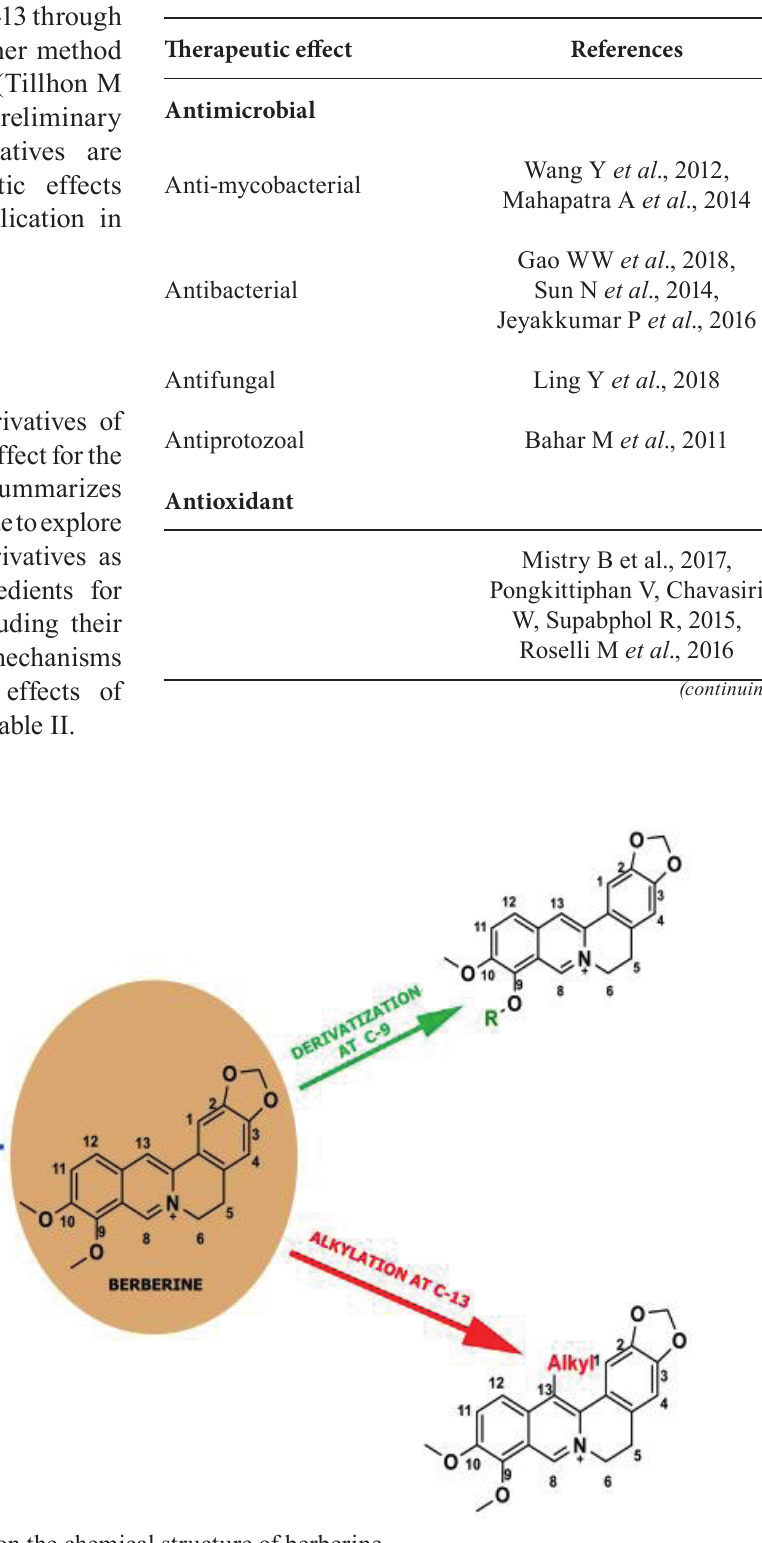
TABLE II - Preliminary studies on pharmacological activity of synthetic berberine derivatives